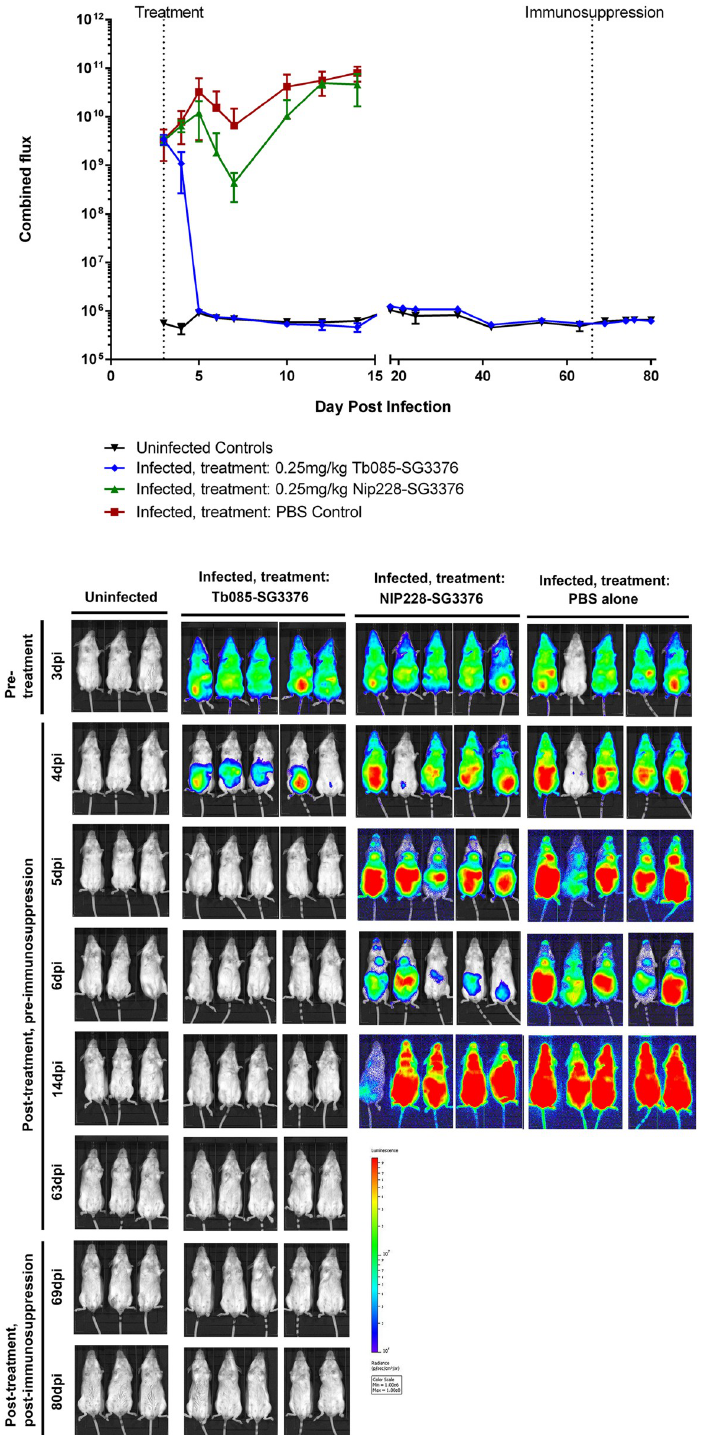
Fig 4. A single low dose of Tb085-SG3376 was able to cure infection in a mouse model of trypanosomiasis. Three groups of 5 mice were infected with pleomorphic T . b . brucei GVR35-VSL2 cells [32, 33], which allow for parasite burden in live mice to be assessed over a time course by bioluminescent imaging (BLI). BLI was performed prior to any treatment at 3 dpi and then at regular time points following treatment on 3 dpi with a single intravenous dose of (1) 0.25 mg/kg Tb085-SG3376 (n = 5), (2) 0.25 mg/kg NIP228-SG3376 (n = 5) or (3) PBS alone (n = 5). Unlike